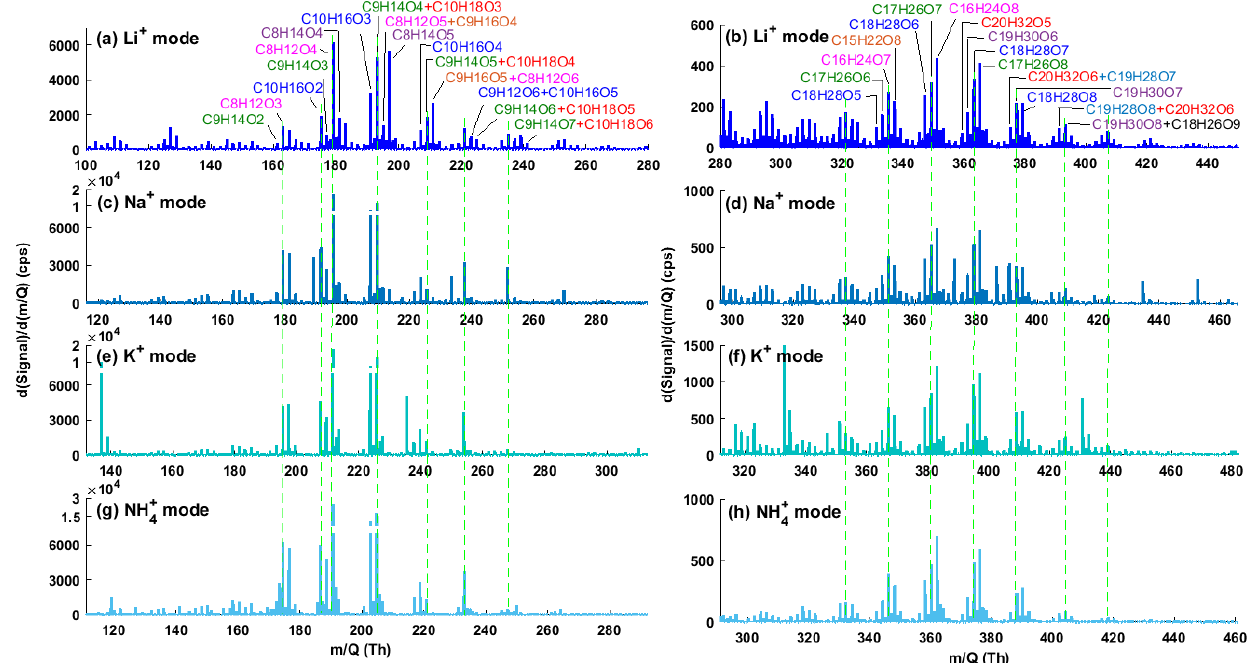
Figure 9. High-resolution mass spectra of α -pinene ozonolysis products in (a, c, e, g) monomer and (b, d, f, h) dimer regions observed in (a, b) Li + mode, (c, d) Na + mode, (e, f) K + mode, and (g, h) NH + mode. The chemical formulae of the detected organics are given for 4 major peaks observed in the mass spectra. To allow direct comparison, the reagent ion adduct has been removed from the detected cluster in each